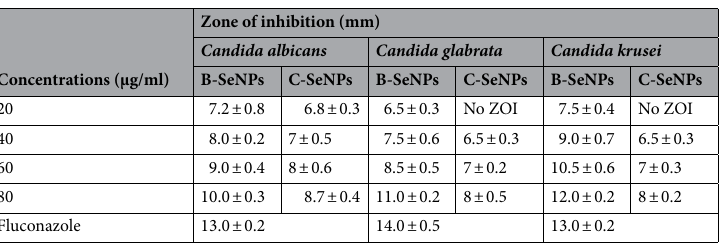
Table 5. Anti-fungal activity of B-SeNPs and C-SeNPs by disc diffusion method.